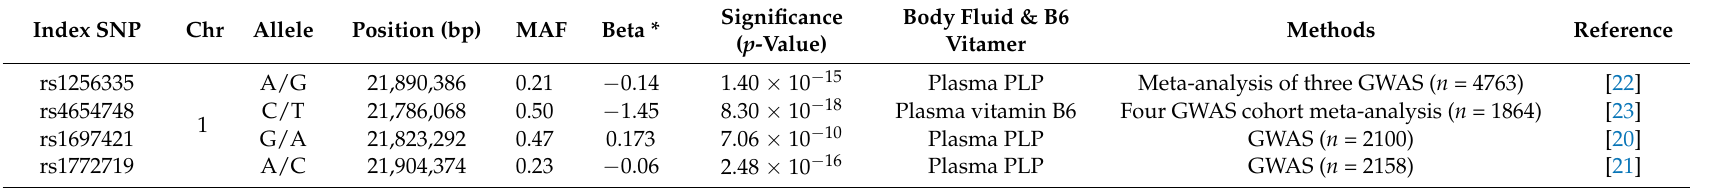
Table 4. Published genome-wide significant associations for plasma vitamin B6